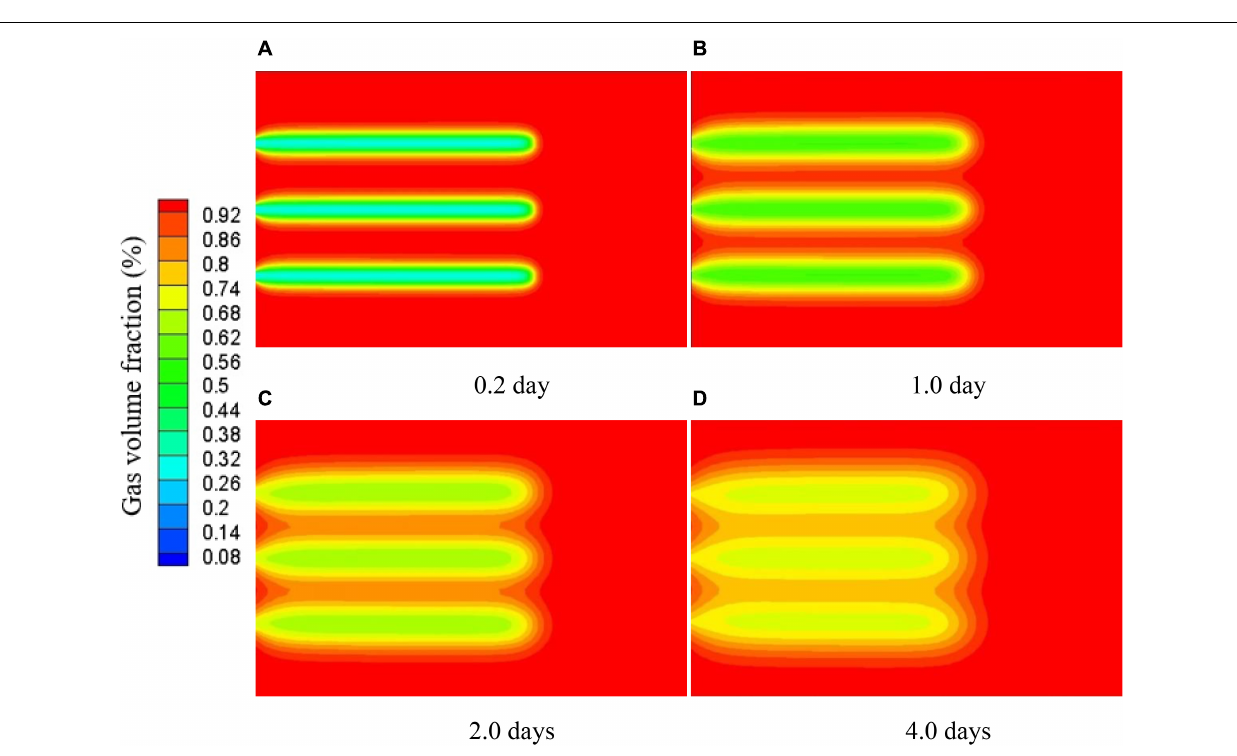
Frontiers in Energy Research |